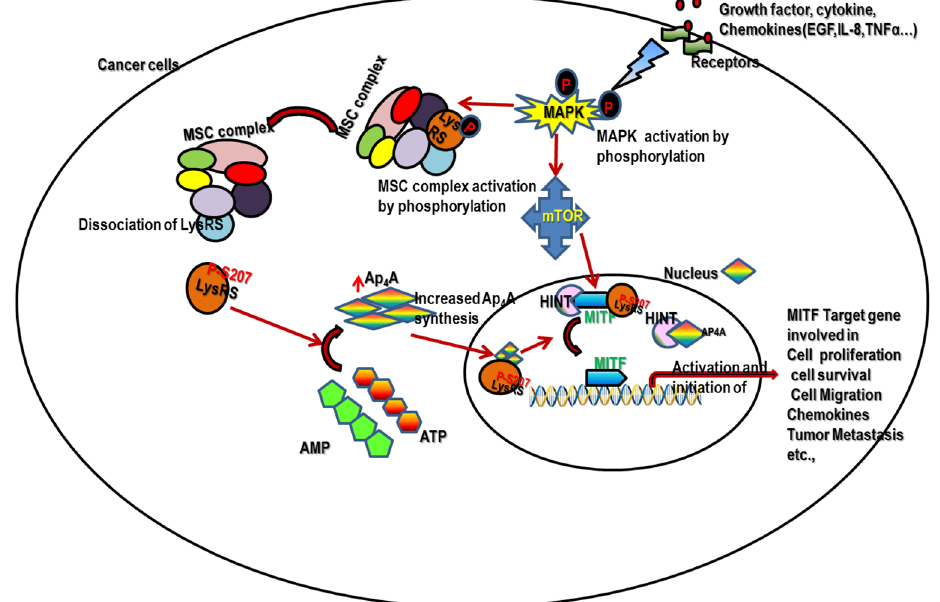
Figure 2. Represents the schematic diagram of pLysRS-Ap 4 A signaling activation during cancer metastasis. During chronic inflammation, the immune cells, such as mast cells (MCs), tumor-associated macrophages (TAMs), etc., release an abundance of growth factors, cytokines, chemokines, prostaglandins, and reactive oxygen species in the tumor microenvironment which can promote tumor metastasis. The released growth factors, chemokines and cytokines cause the activation of the pLysRS-Ap 4 A-regulated MITF pathway. Thus, it promotes cancer cell survival, proliferation, migration and metastasis. Hence, the pLysRS-Ap 4 A-regulated MITF pathway is the main hallmark in both cancer and immune cells.